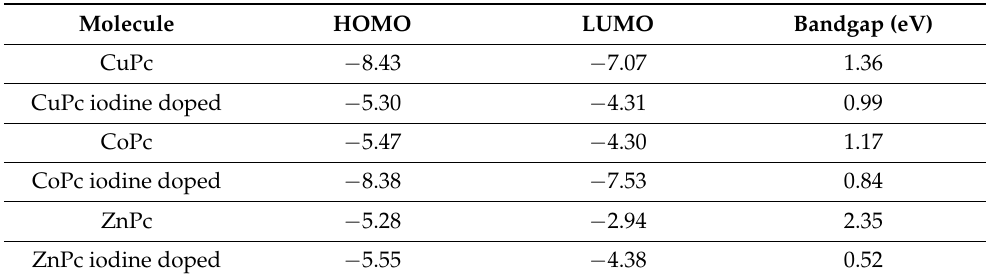
Figure 3. Frontier molecular orbitals of ( a ) CuPc, ( b ) CoPc and ( c ) ZnPc iodine doped. Table 1. HOMO, LUMO and bandgap of the intrinsic and doped MPcs (M = Cu, Co, Zn).